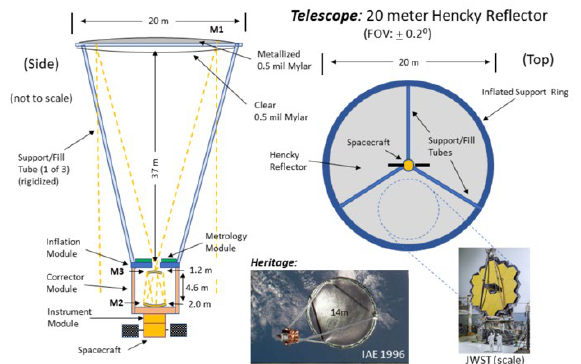
Fig. 1. Inflatable 20-meter Mylar balloon-based terahertz OASIS telescope concept design and configuration. [2]